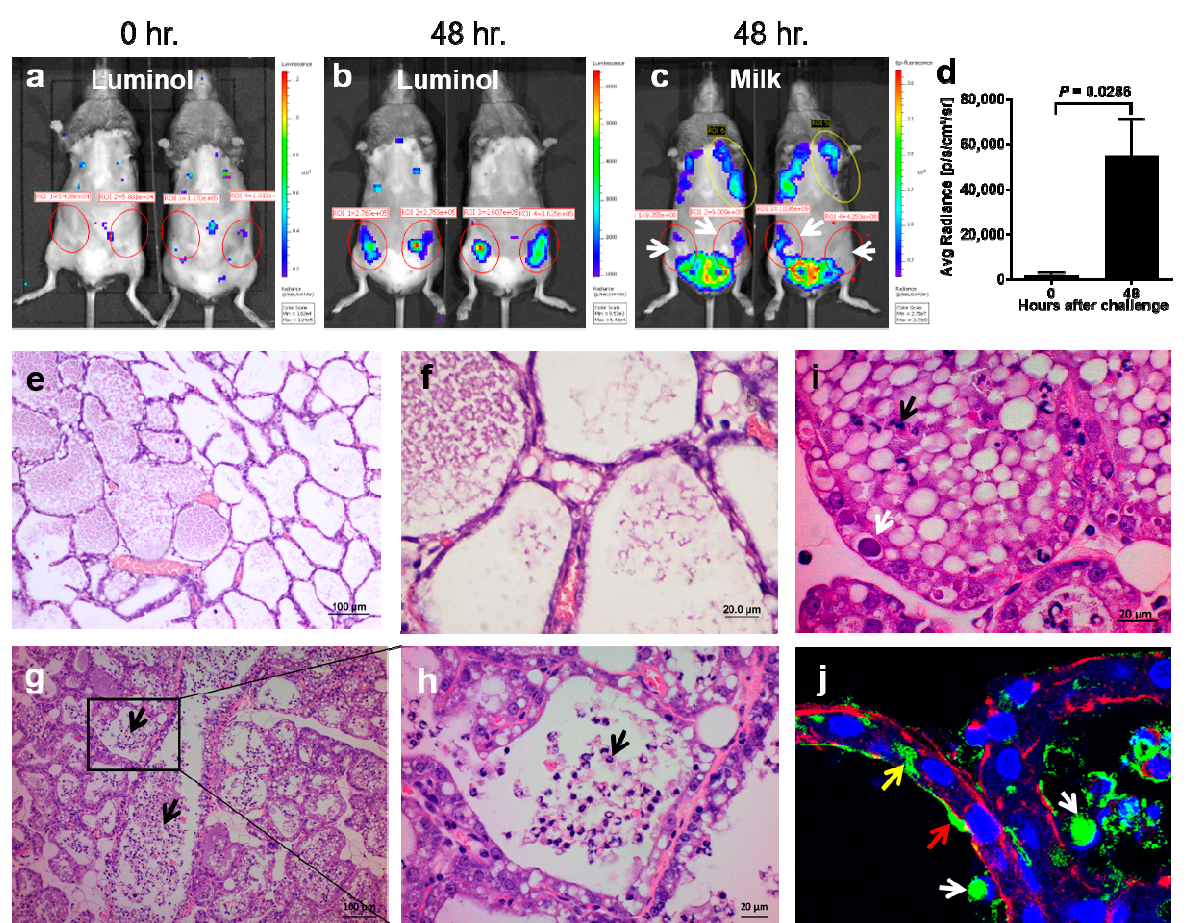
Figure 2. Characterization of the murine M. bovis strain 161791 mastitis model. Mammary virulence of M. bovis was demonstrated in lactating C3H/HeN mice following IMM challenge of L4 and R4 glands. ( a , b ) Bioluminescence imaging of neutrophil recruitment and ( d ) difference in mammary inflammation represented by luminescence intensity measured at time 0 and 48 h after challenge. ( c ) The effect of disease on milk quantity in the glands. Loss of milk in the affected glands (red circle) in comparison to non-challenged glands (yellow circle) is shown by white arrows. ( e – i ) H&E stain- ing of tissue samples of normal control and challenged glands. ( e , f ) The control mammary gland is normal and free of disease signs, while massive neutrophil recruitment is visible in challenged glands (black arrows in ( g – i )). Large colonies of M. bovis, identified in mMECs, are marked by white arrow ( i ). ( j ) Cryosections of mammary tissue were stained with phalloidin (red), DAPI (blue), and polyclonal-anti M. bovis antibody (green) and analyzed using confocal microscopy showing a single Z-stack. Microscopic image demonstrates M. bovis microbial communities adherent to the apical membrane of mammary alveolar epithelium (red arrow in ( j )), intraepithelial M. bovis communities (yellow arrow in ( j )), and M. bovis bacteria phagocytosed by alveolar neutrophils (white arrows in ( j )). Scale bars; 100 μ m ( e , g ) and 20 μ m ( f , h , i ). Image ( i ) original magnification ×40. Representative images of ≥ 6 mice.